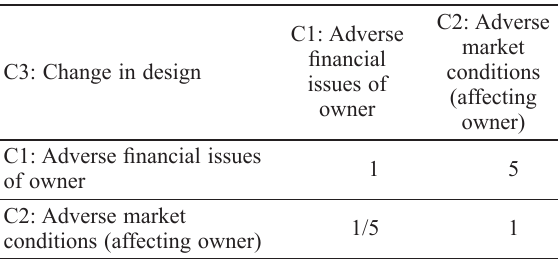
Table 4. Relative importance weight of C1: adverse financial issues of owner and C2: adverse market conditions (affecting owner) with respect to C3: change in